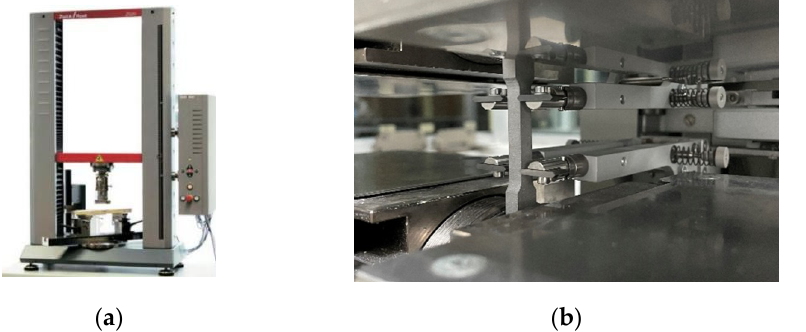
Figure 8 . Schematic diagram of tensile test: ( a ) Zwick electronic universal testing machine; ( b ) sample clamping state .